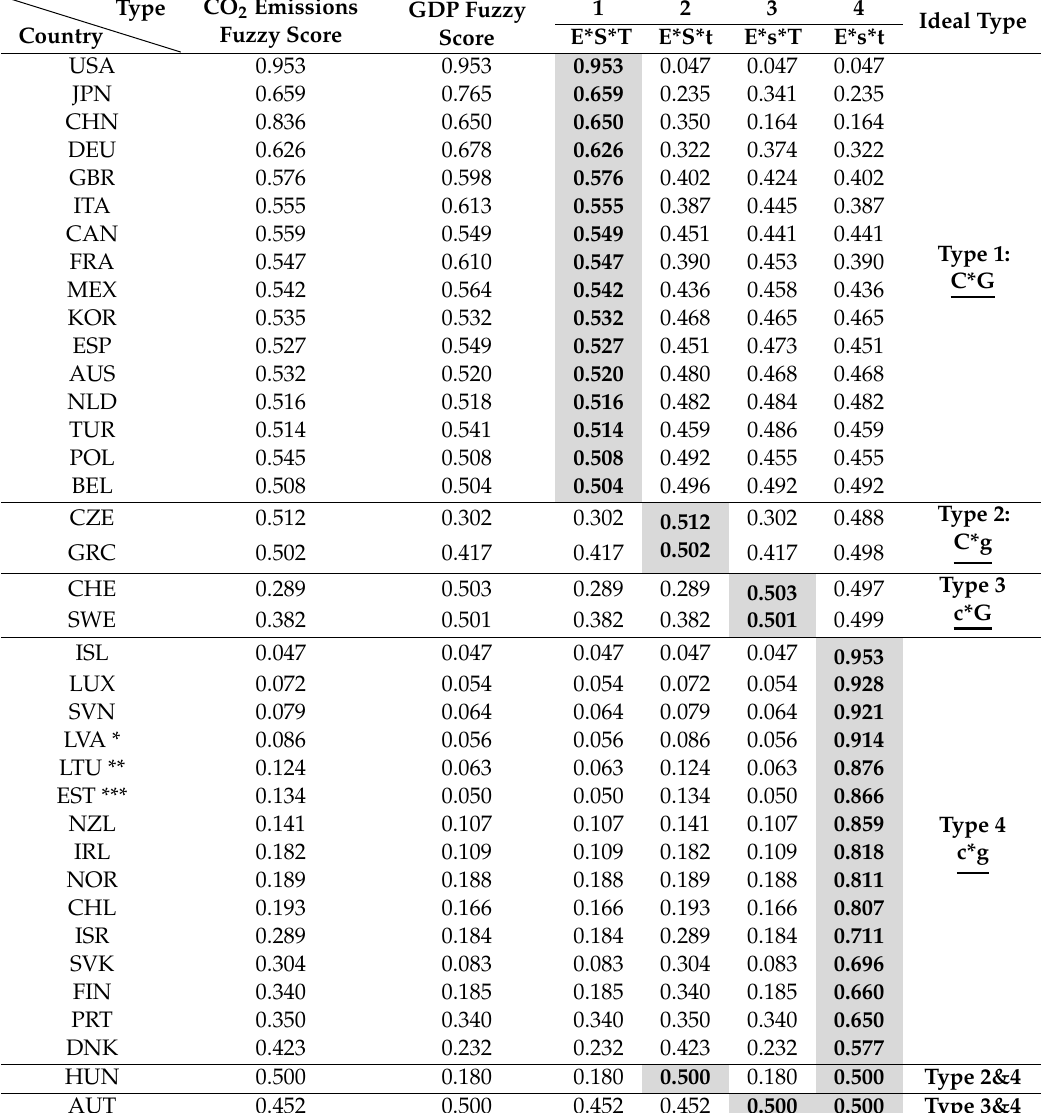
Table 4. Results of Fuzzy-set Ideal Type Analysis